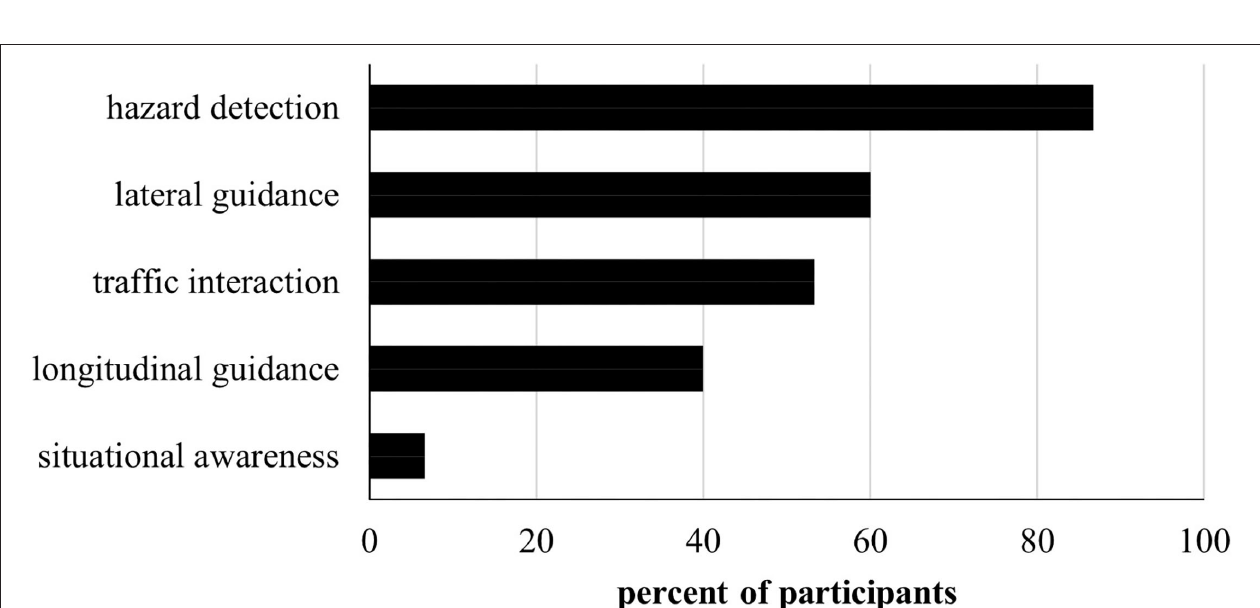
FIGURE 4 | Number of participants confirming the experience of problems concerning hazard detection, lateral and longitudinal guidance, traffic interaction, and general situational awareness during simulated VFL compared to NV.